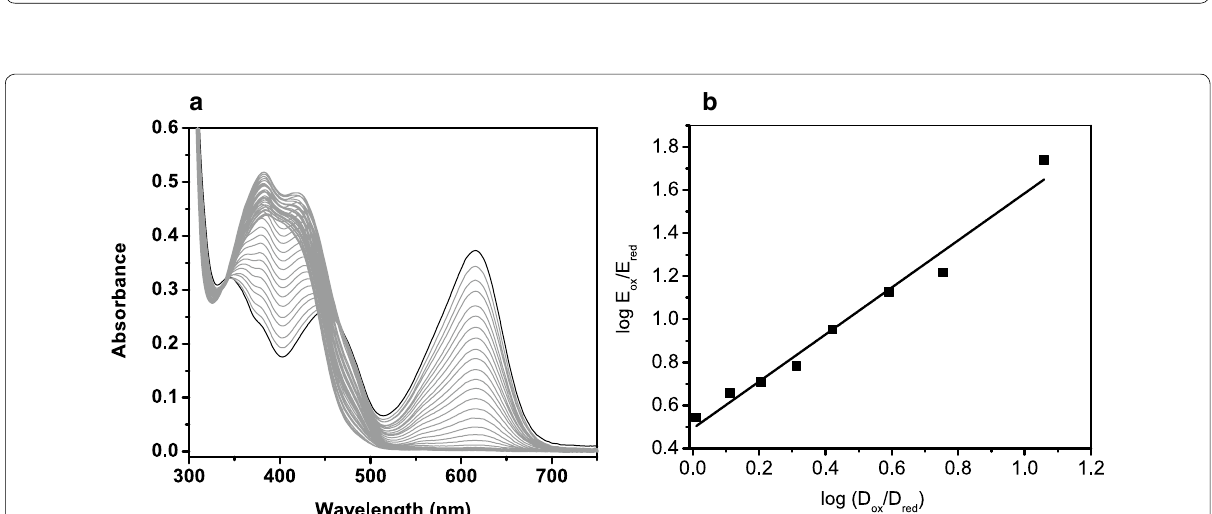
Fig. 4 Reduction potential measurement of GSTACMO. a The combined absorbance spectra of GSTACMO and indigo disulfonate as both species are slowly reduced with xanthine/xanthine oxidase. The standard reduction potential value of the enzyme (E°), calculated from the y-intercept of the plot of log ( E red / E ox ) versus log ( D red / D ox ) shown in b , is